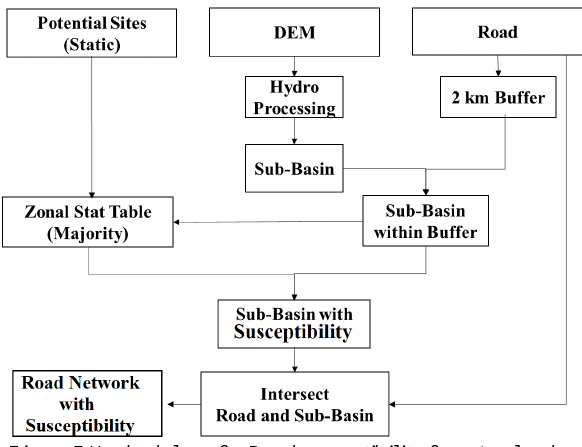
Figure 7 Methodology for Road susceptibility from Avalanche.